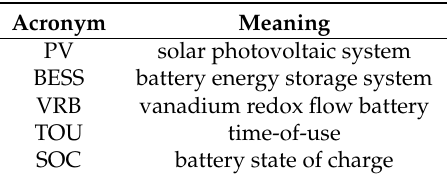
Table 1. Table of